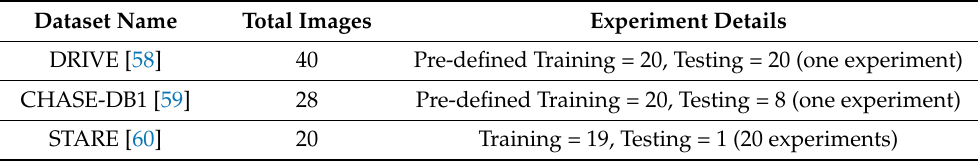
Table 4. Description of the DRIVE, STARE, and CHASE-DB1 datasets and experimentation details.